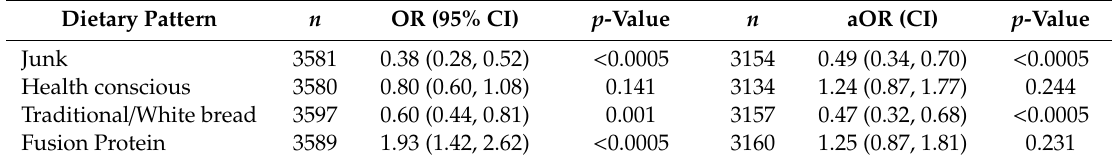
Table 3. Unadjusted and adjusted odds of having GDM for women with intakes in the highest tertile compared to those with intakes in the lowest tertile of each dietary pattern.